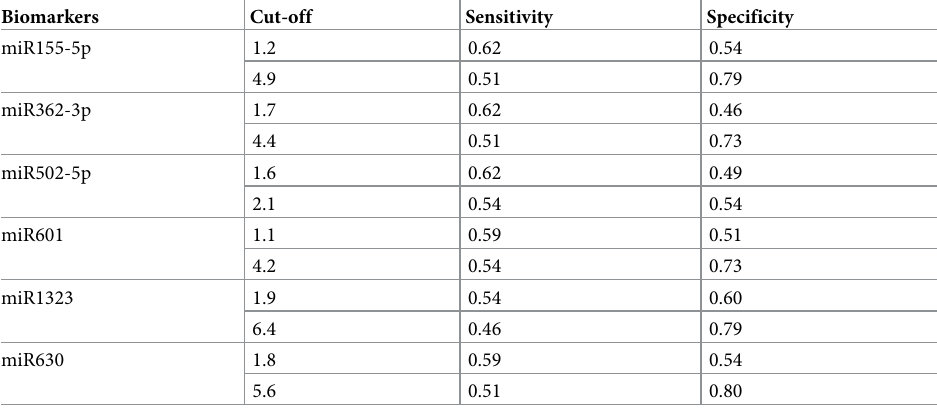
Table 3. Serum miRNAs level at the best cut-off values for diagnosis severe leptospirosis. Biomarkers Cut-off Sensitivity